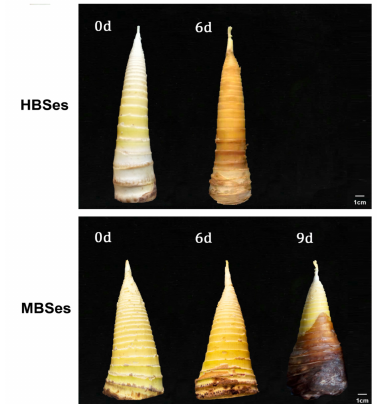
Figure 1. Changes in the surface quality of two varieties of bamboo shoots at room temperature. HBSes, high bamboo shoots; MBSes, moso bamboo